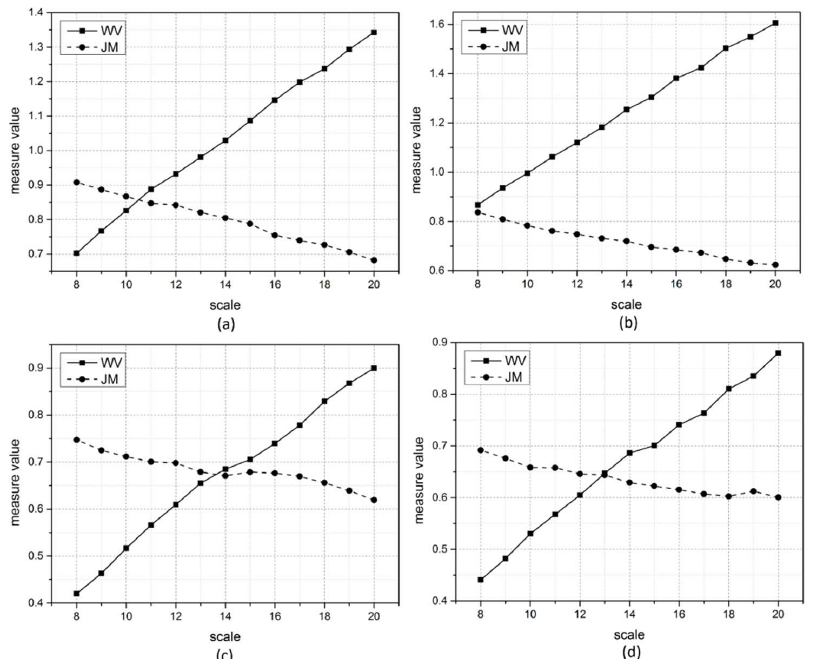
Figure 4. The WV and JM values of the segmentation results, produced by multiresolution segmentation (MRS) method with the scale from 8 to 20, for the four study areas of ( a ) T1, ( b ) T2, ( c ) T3, and ( d )T4.